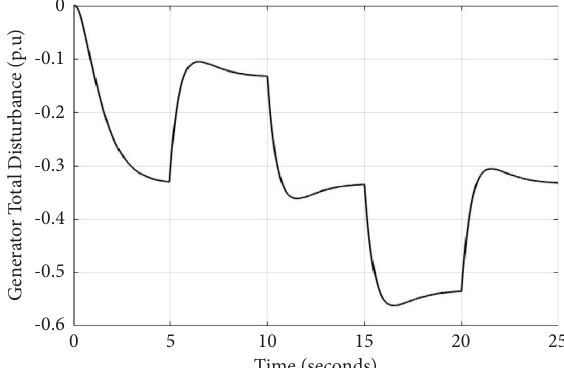
Figure 7: Estimation of generator total disturbance under +50% parametric uncertainties in ( T Table 5: Dynamic response specifcation of AVR under − 50% parametric uncertainties in T